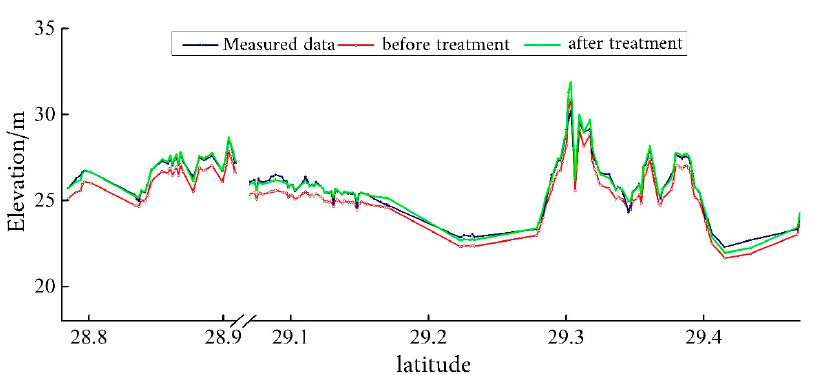
Figure 10. Comparison of Ice, Cloud, and Land Elevation Satellite’s Geoscience Laser Altimeter System data before and after correction as well as the measured elevation data.